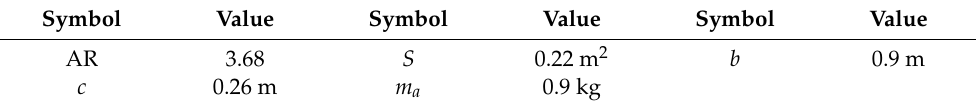
Figure 1. Small battery-powered flying wing UAV. Table 1. Numerical values of the UAV.